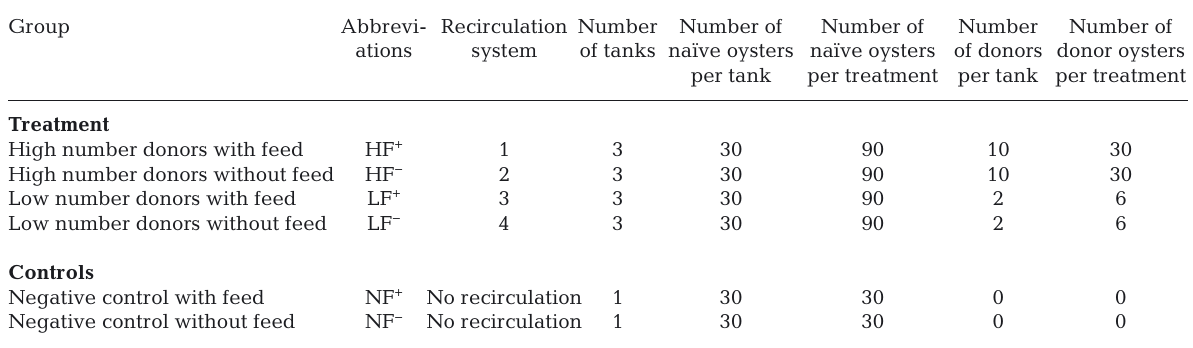
Table 1. Design of Expt 1 to assess the effects of food presence and the number of OsHV-1 infected donor oysters on OsHV-1 in- fection and clinical disease. OsHV-1 donor oysters received intramuscular injection of OsHV-1 inoculum 1 h prior to